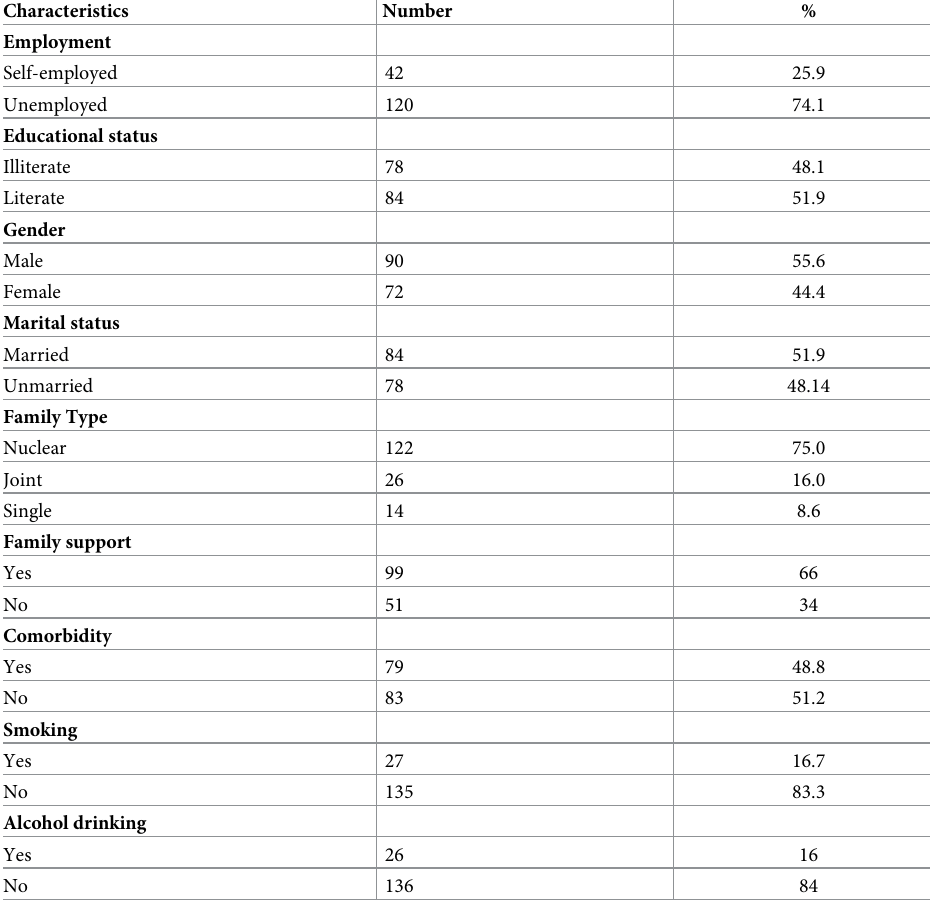
Table 1. Distribution of participants by their socio-demographic and health behavioral